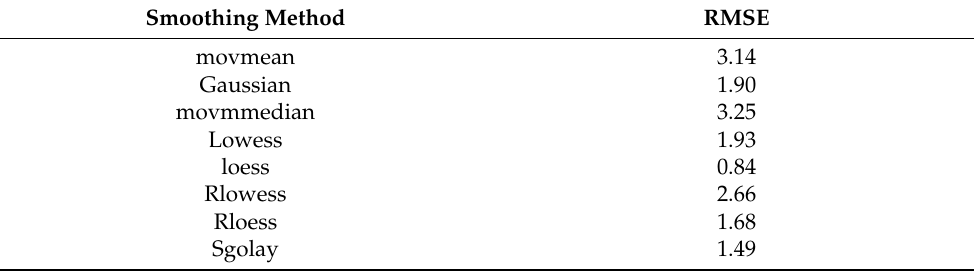
Table 3. Experimental parameter setting